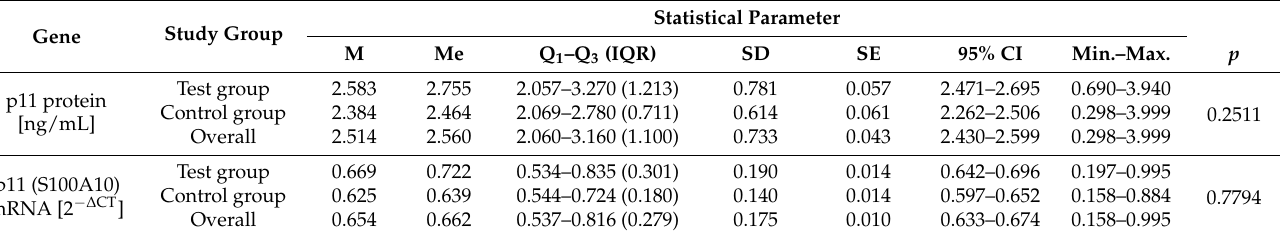
Table 2. Detailed descriptive statistics for p11 gene expression by study group.